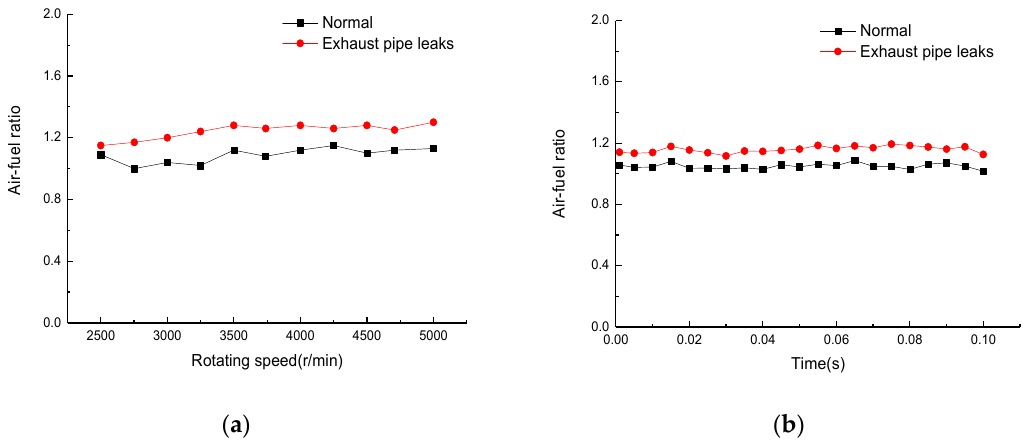
Figure 7. Air-fuel ratio diagram of exhaust pipe leakage and normal conditions. ( a ) Chart of air-fuel ratio changing with rotating speed, ( b ) Change chart of transient air-fuel ratio.